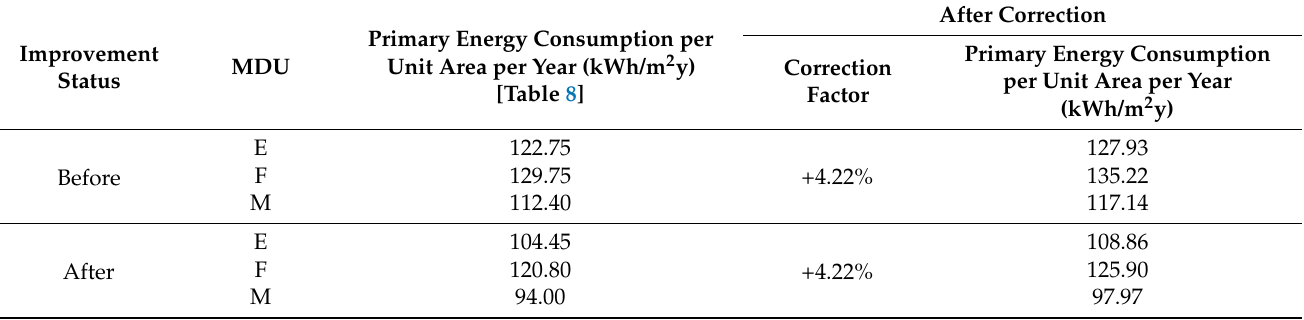
Table 10. Results of the correction of the primary energy consumption of the final E, F, and M complexes, applying the heating coefficient correction and the ventilation system correction